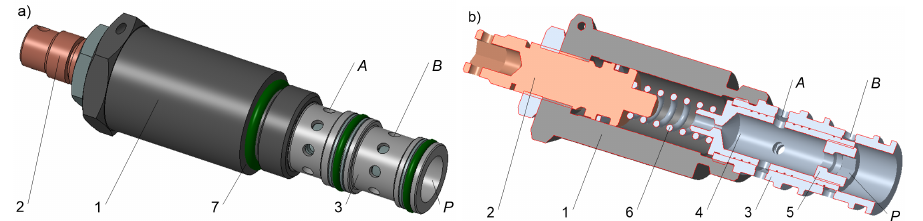
Figure 2. Cartridge flow regulator: ( a ) view, ( b ) section; 1—body, 2—adjuster, 3—sleeve, 4—spool, 5—nozzle, 6—spring, 7—sealing; P—supply port, A—output port, B—relief port.